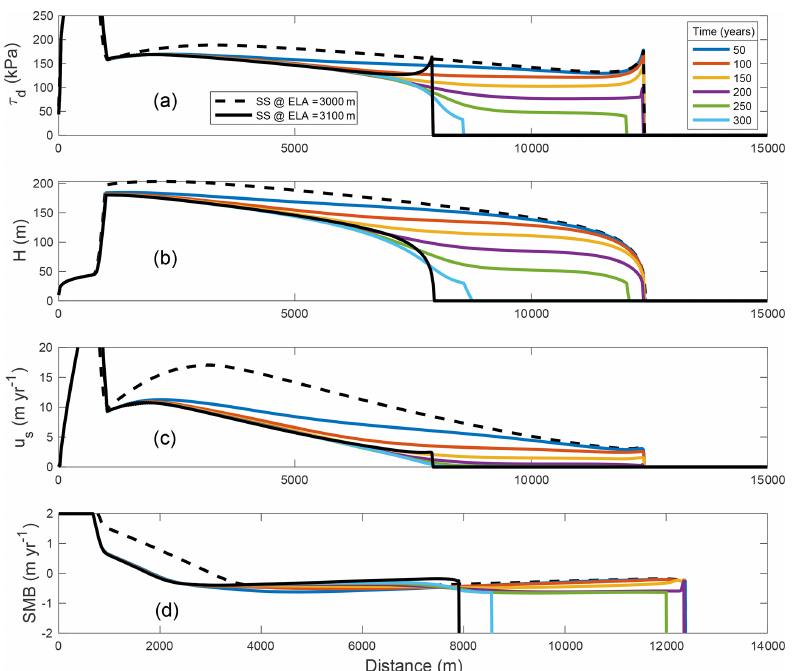
Figure B1. Effect of glacier retreat in response to step change in ELA from 3000 to 3100m on profiles of (a) driving stress τ d , (b) ice thickness H , (c) surface velocity u s , and (d) surface mass balance at time intervals of 50 years. The dashed black and solid black lines, respectively, refer to the initial and final steady states (SS) of the retreat experiment.